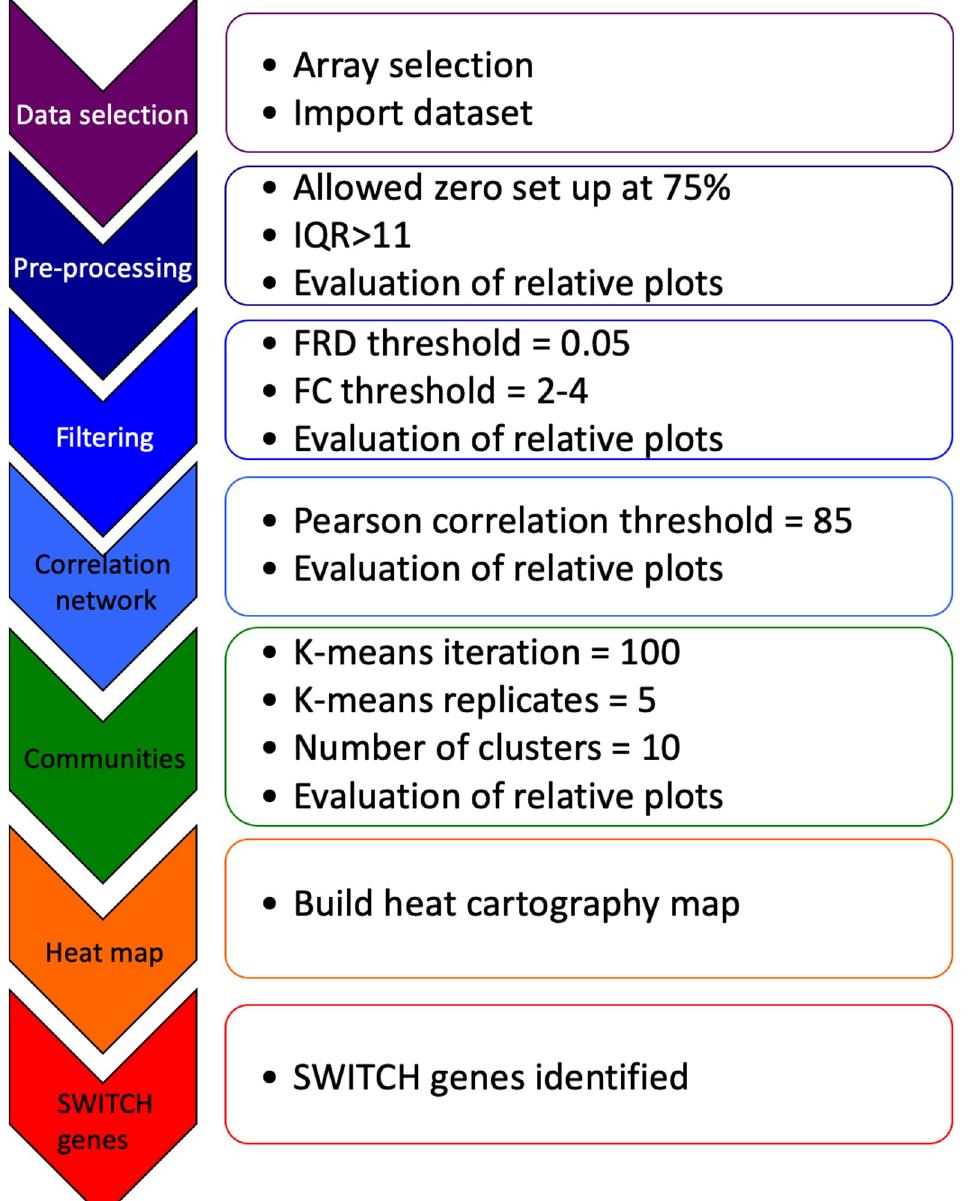
Fig 2. SWIM analysis to identify switch genes. Data from the expression arrays was imported into SWIM. The SWIM algorithm is comprised of the steps depicted in the figure [31]. For each brain section and each group, diseased and normal, the mean value of the gene expression is calculated for every cell in the microarray. The p-value is then calculated for each gene. Control for the false discovery rate is performed using the Benjamini and Hochberg approach. The sets of genes to analyze is further filtered by setting thresholds for the magnitude of the fold change and false discovery rate. Next, the Pearson correlation coefficient is calculated for the remaining pairs of genes and those below a threshold are eliminated. At this point 1000 to 2000 genes out of the original 54675 remain. These genes become the nodes in the network that will be